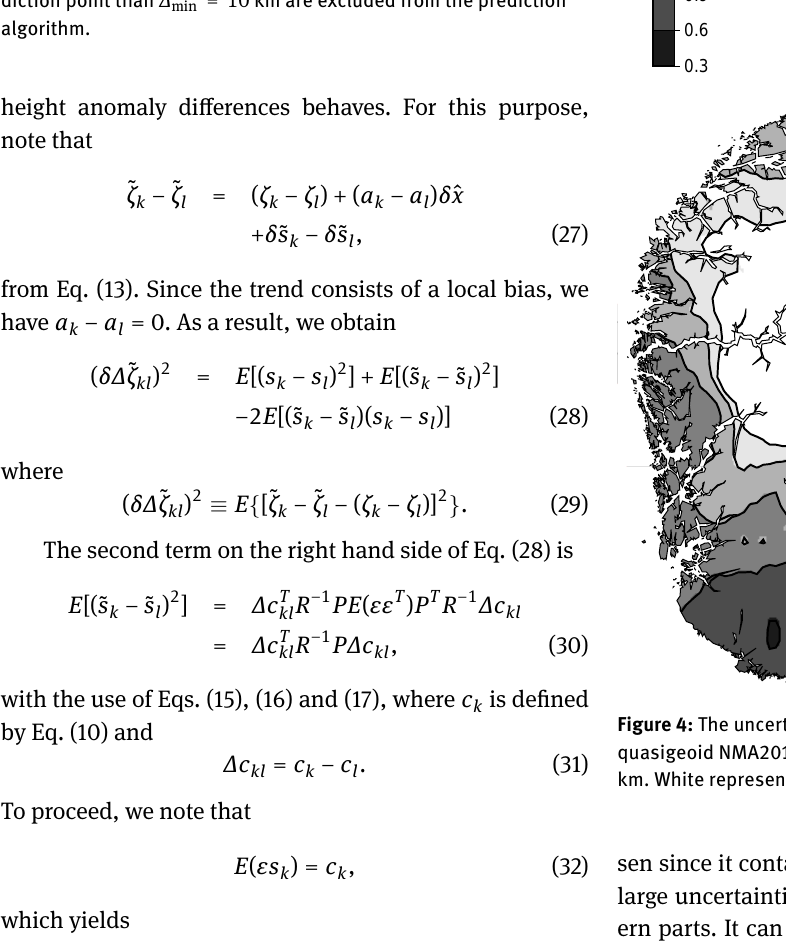
Figure 3: The distribution of normalized prediction errors for the Hordaland region (NMA2013v30). Observations closer to the pre- diction point than ∆ min = 10 km are excluded from the prediction algorithm.